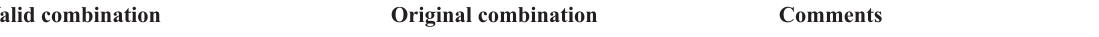
Table 3. Holarctic species in Psyllinae Latreille, 1807 associated with Betulaceae referrable to Psylla Geoffroy, 1762. Taxa sampled in Percy et al . (2018) are indicated with an asterisk. Valid combination Original combination